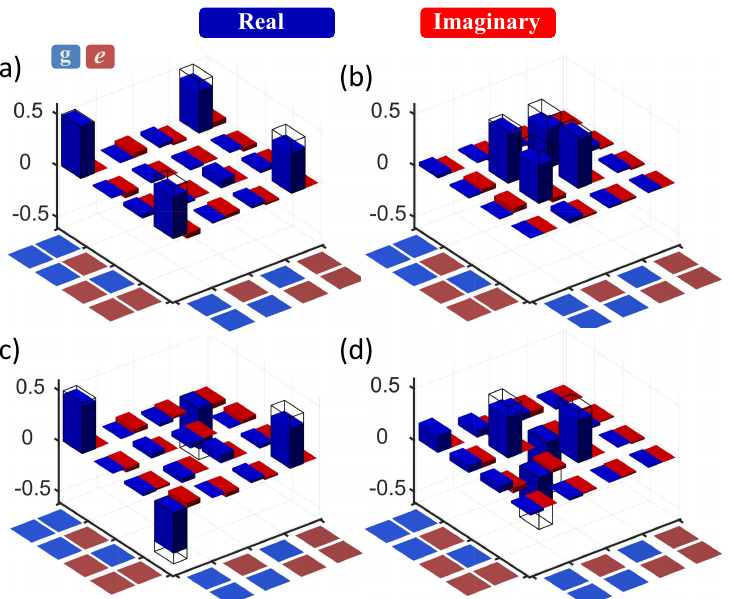
Figure 3. Simulated tomography of Q 1 − Q 2 density matrices conditional on the four double- measurement outcomes of Q a , which distinguish the states of the two cavities in order to project ( Q 1 , Q 2 ) to a specific entangled state. ( a ) | g (cid:105) 1 st | g (cid:105) 2 nd → |C + (cid:105) C ( b ) | g (cid:105) 1 st | e (cid:105) 2 nd → |C + (cid:105) C ( d ) | e (cid:105) 1 st | e (cid:105) 2 nd → |C − (cid:105) C